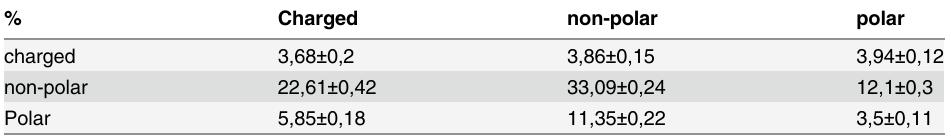
Table 2. Relative frequency of the various type of amino acid substitutions within the TM regions associated with diseases. % Charged non-polar polar charged 3,68 ± 0,2 3,86 ± 0,15 3,94 ± 0,12 non-polar 22,61 ±